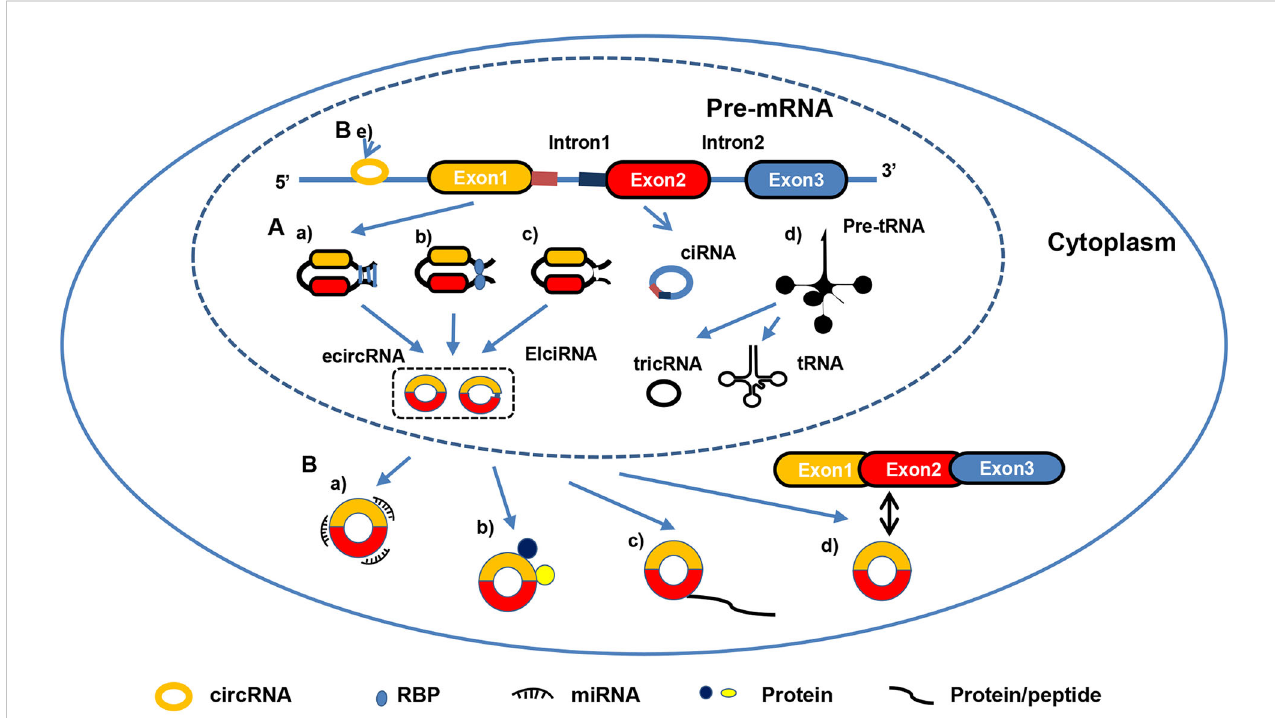
FIGURE 1 Biogenesis and functions of circRNA. (A) CircRNA biogenesis: (a) Intron pairing-driven circularization; (b) RBP-driven circularization; (c) spliceosome- dependent lariat-driven circularization; (d) TricRNA biogenesis by pre-tRNA intron splicing. (B) CircRNA functions: (a) Sponging miRNAs; (b) binding to proteins; (c) translating proteins/peptides; (d) competing with splicing of pre-mRNA; (e) binding DNA to regulate gene